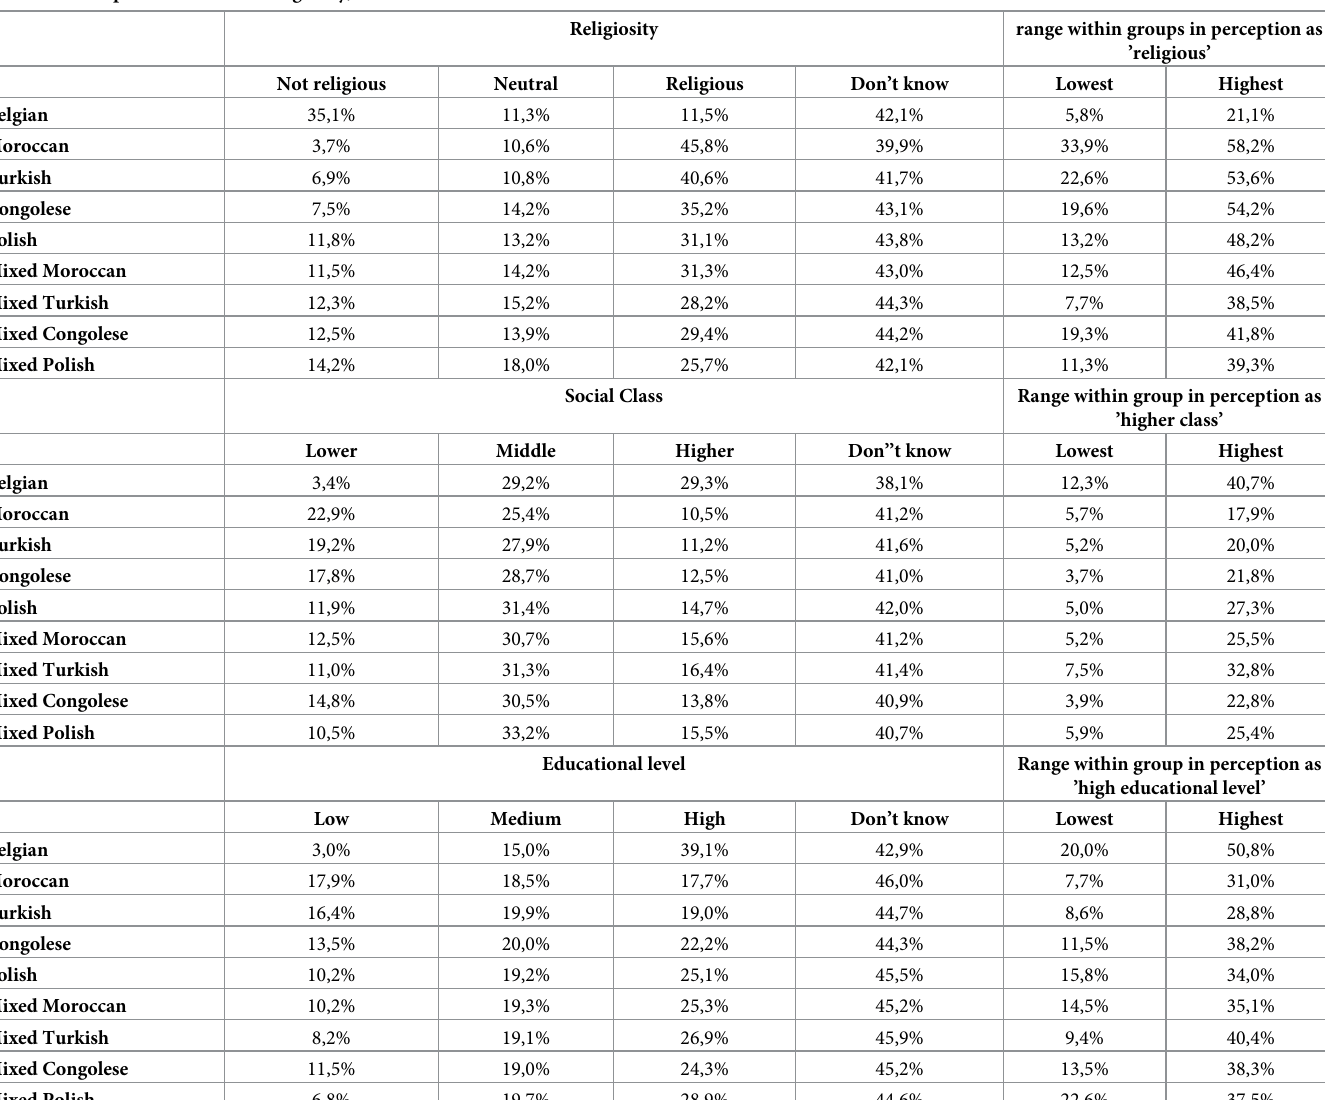
Table 3. Descriptive statistics for religiosity, social class and educational